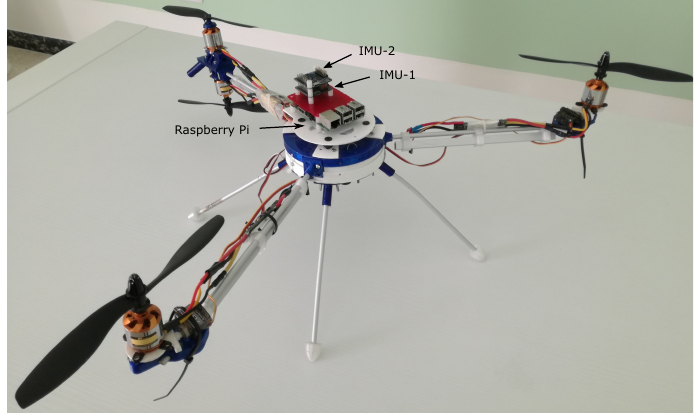
Figure 5. A picture of the custom tri-rotor aircraft used in the flight test with the duplex hardware platform on top.